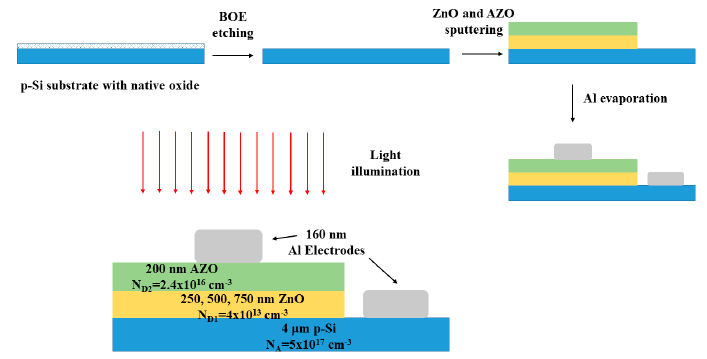
Figure 1. Fabrication process and structural details of the p-Si/i-ZnO/n-AZO heterostructure.